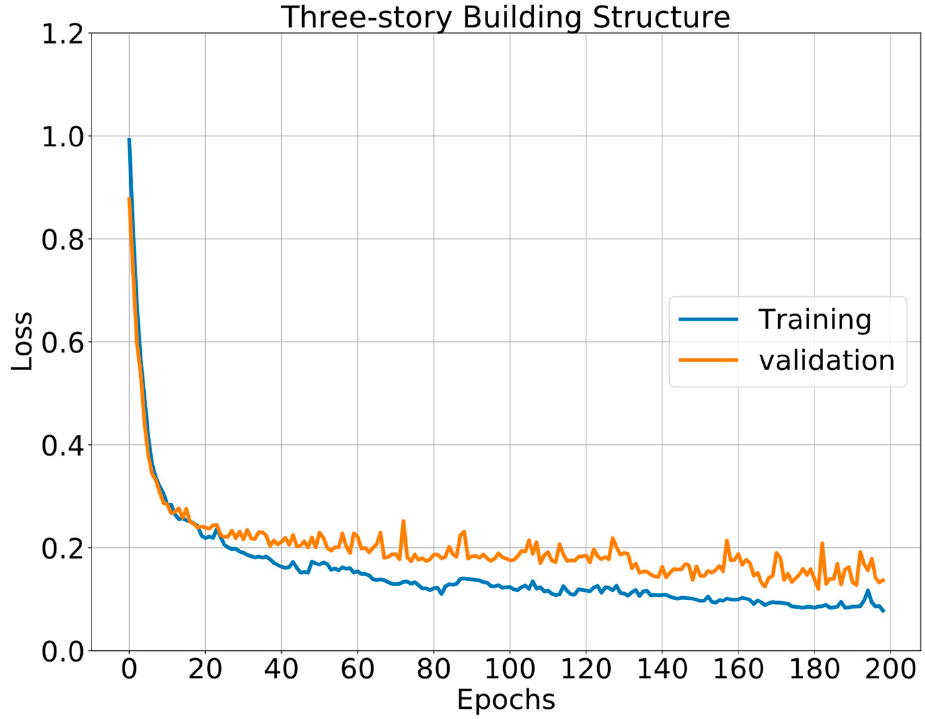
Figure 8. Loss curves of EEMD-PCC-CNN during the training procedure.